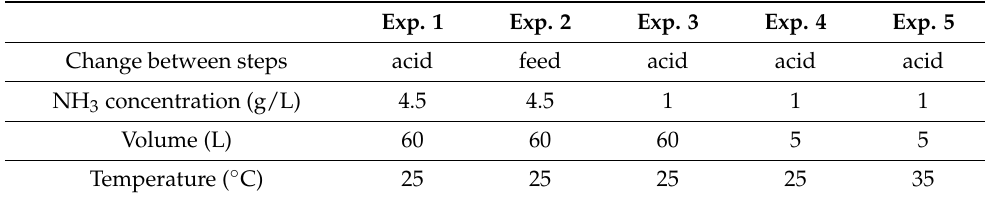
Table 1. Experimental